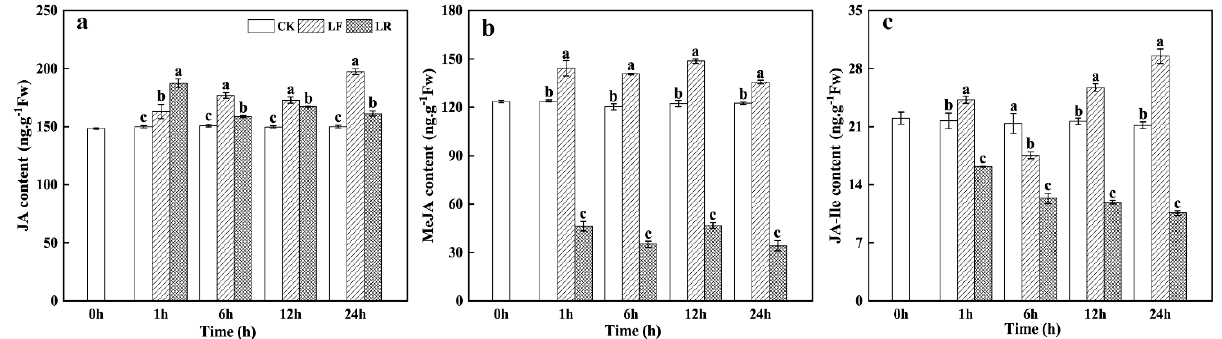
Figure 1. Effect of leaf removal on levels of endogenous jasmonic acid (JA) ( a ), methyl jasmonate (MeJA) ( b ), and jasmonate isoleucine (JA–Ile) ( c ) in the roots of M. baccata under suboptimal low root–zone temperatures. Means ( ± SE) of three replicates are shown for each treatment at each time point independently. Different lowercase letters on the bars indicate significant differences between treatments. CK: control; LF: suboptimal low root-zone temperatures treatment (with leaves); LR: leaf removal treatment under suboptimal low root-zone temperatures. The same abbreviations are used